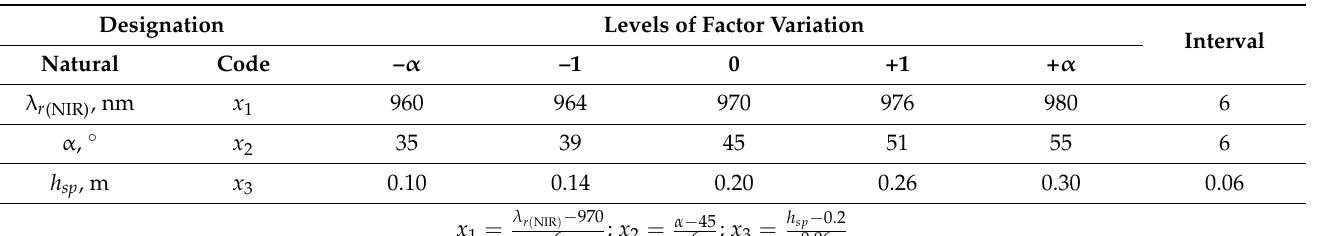
Table 2. Values of the factors and the levels of their variation in the implementation of the experiment plan for Scots pine seeds’ NIR